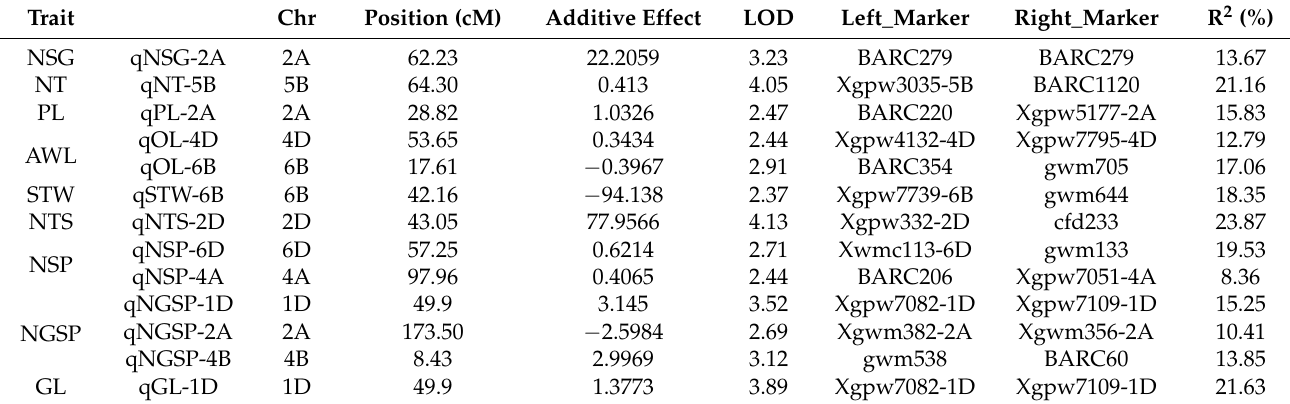
Table 8. QTLs identified using the F8 population derived from Gonbad × Kohdasht in